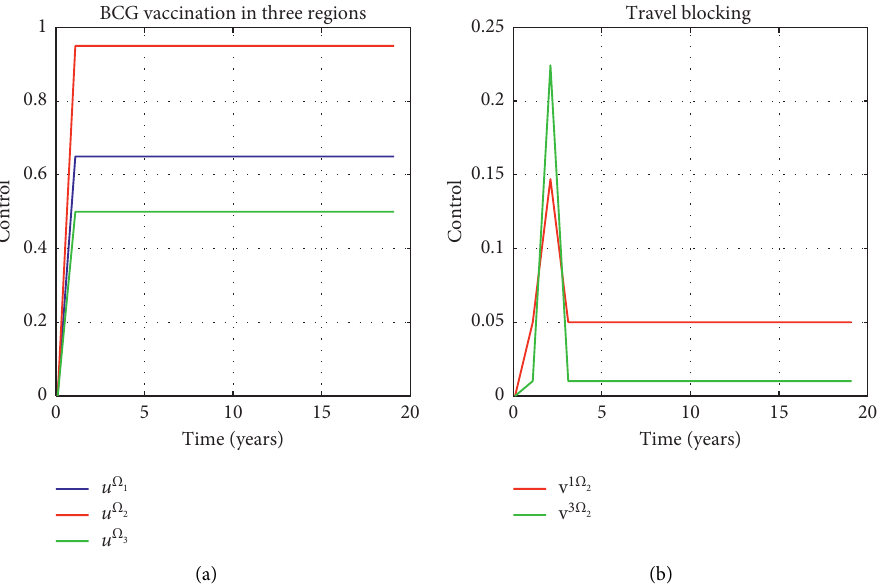
Figure 6: The BCG vaccination and travel-blocking control in three